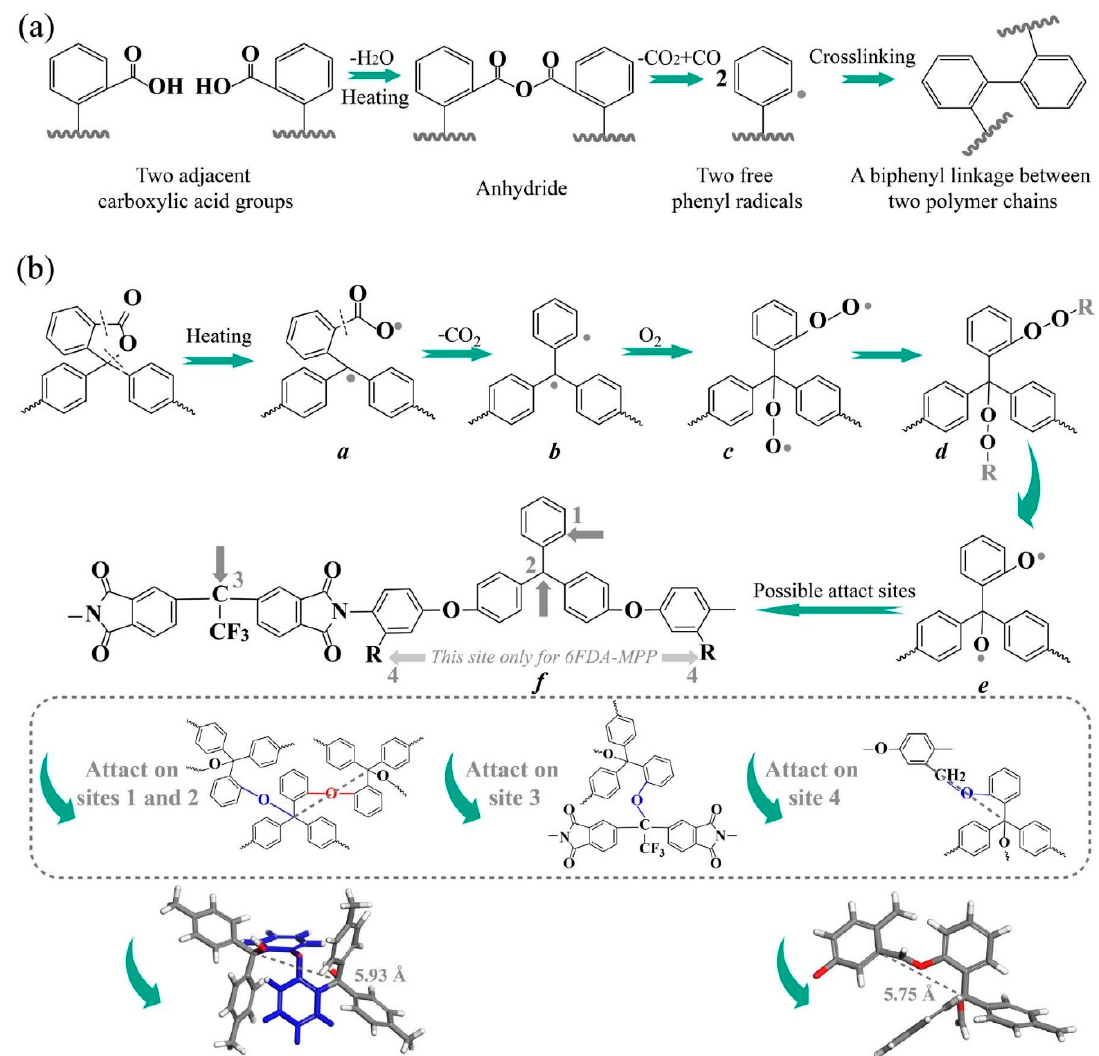
Figure 8. ( a ) The thermal crosslinking mechanism of carboxylic acid-containing polyimides, and ( b ) the thermal oxidative crosslinking mechanism of phenolphthalein-based polyimides as well as the energy-minimized distances between the possible crosslinking sites estimated using Material Studio 7.0 [59].